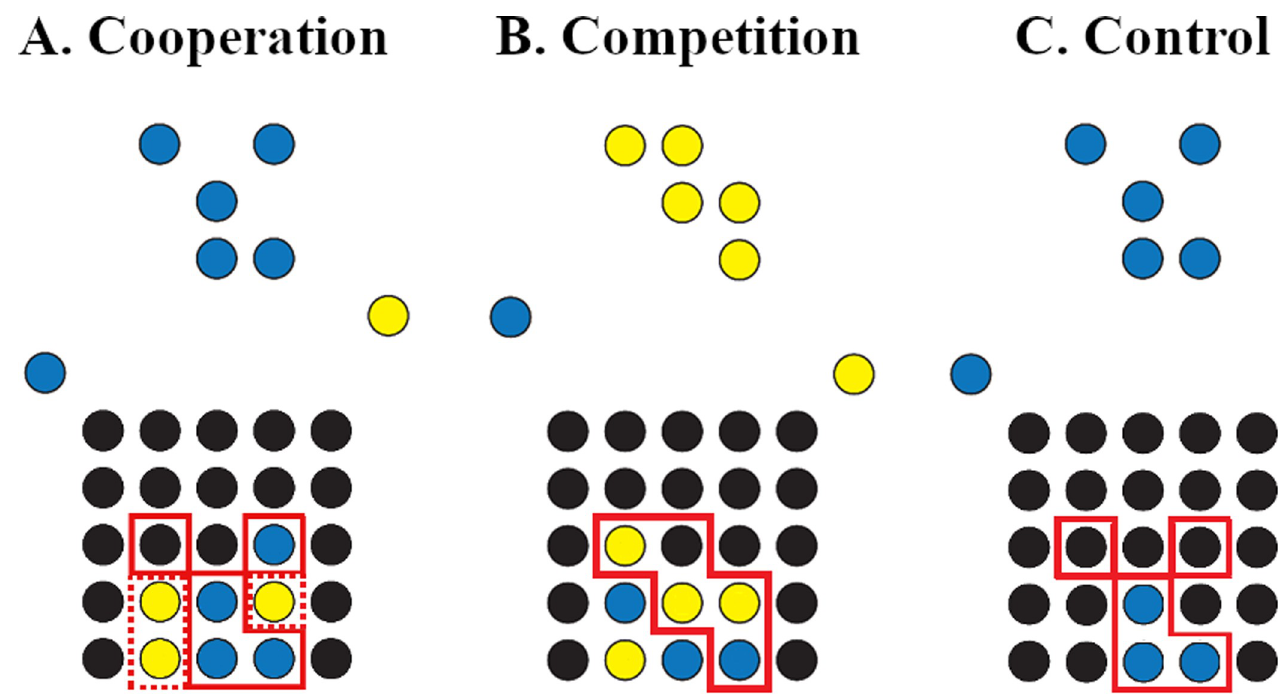
Fig 1. Schematics of the Co-operation ( A ), Competition ( B ) and Control conditions ( C ). In all examples, the Builder is assigned to the same colour as the target pattern and scores by placing tokens in locations that recreate the pattern (solid red lines). In Co-operation and Competition rounds, the Other is assigned to the opposing colour and must place their tokens in locations that serve to help or hinder the Builder (dashed red lines); since the latter is achieved by placing tokens within the pattern space, thereby obstructing the Builder, the scoring location of Others and Builders are the same in Competitive rounds.